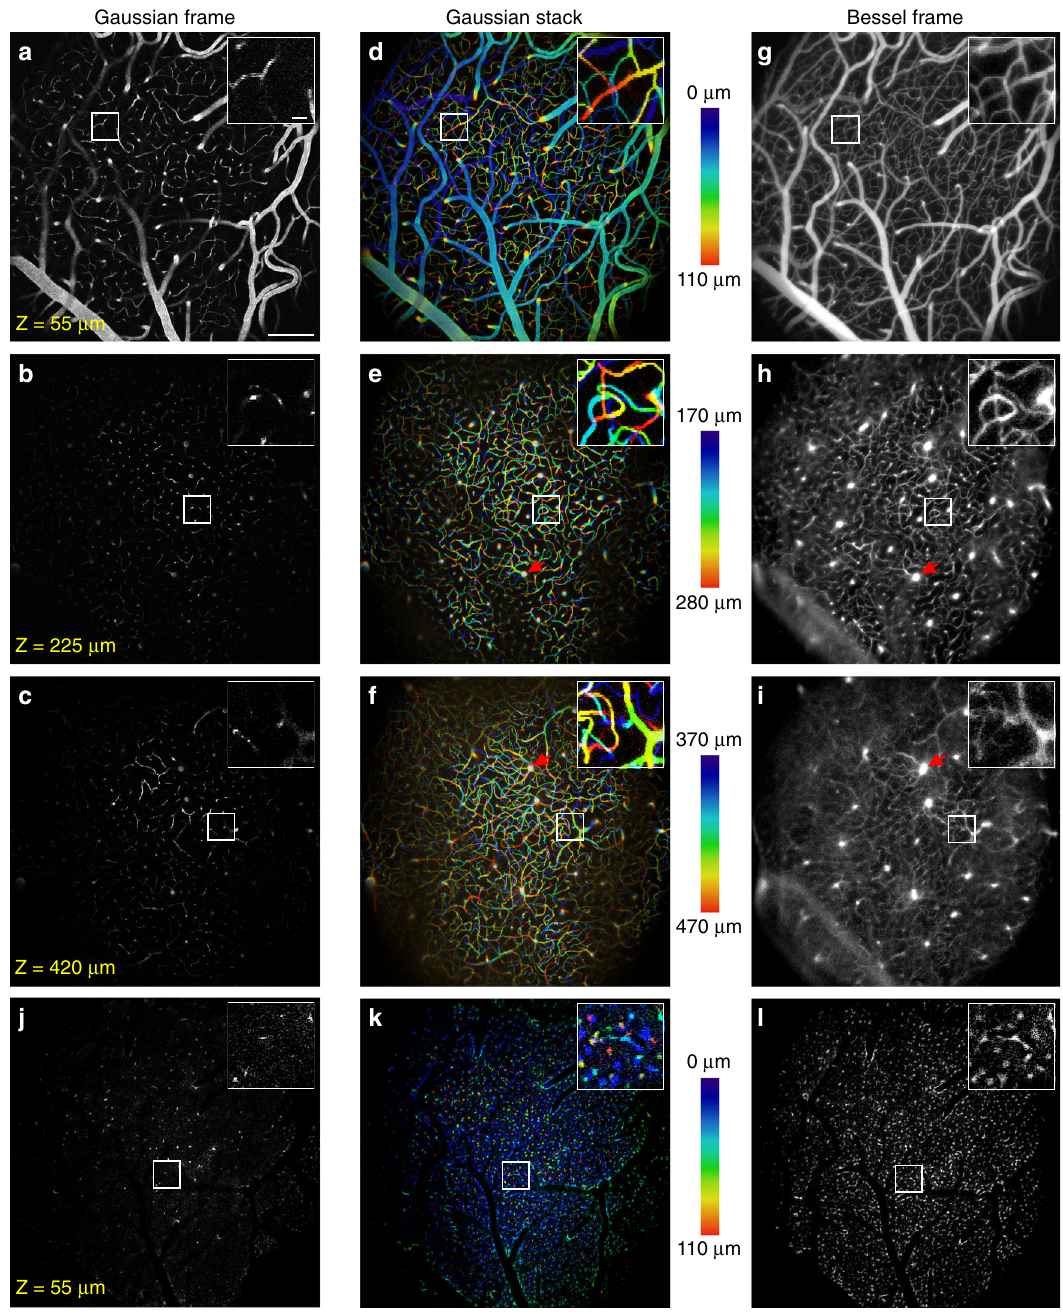
Fig. 2 In vivo volumetric structural imaging of vasculature and glia with Bessel TPLSM. a – c Gaussian TPLSM images of vasculature labeled with dextran- conjugated Texas Red at 55 µ m, 225 µ m, and 420 µ m depths, respectively, over a 1.4 mm × 1.4 mm area in the mouse cortex in vivo. d – f Gaussian TPLSM image stacks of vasculature at 0 – 110 µ m, 170 – 280 µ m, and 370 – 470 µ m depths, respectively, color-coded by depth. g – i Scanning the Bessel focus in 2D captured all vasculature in the volumes within ( d – f ). j – l Gaussian ( j , k ) and Bessel ( l ) images of GFP-expressing glia imaged concurrently with a , d , and g , respectively. Insets: zoomed-in views of the white-boxed regions. Red arrowheads: vessels oriented parallel to the Bessel focus; a and g use a grayscale on the normalized square root of fl uorescence signal to highlight dim structures without saturating bright structures. All other panels use grayscale on the normalized linear fl uorescence signal. Representative data from four mice. Scale bars: 200 µ m for full FOV; 20 µ m for insets. Post-objective excitation power: Gaussian: 45 – 177 mW; Bessel: 217